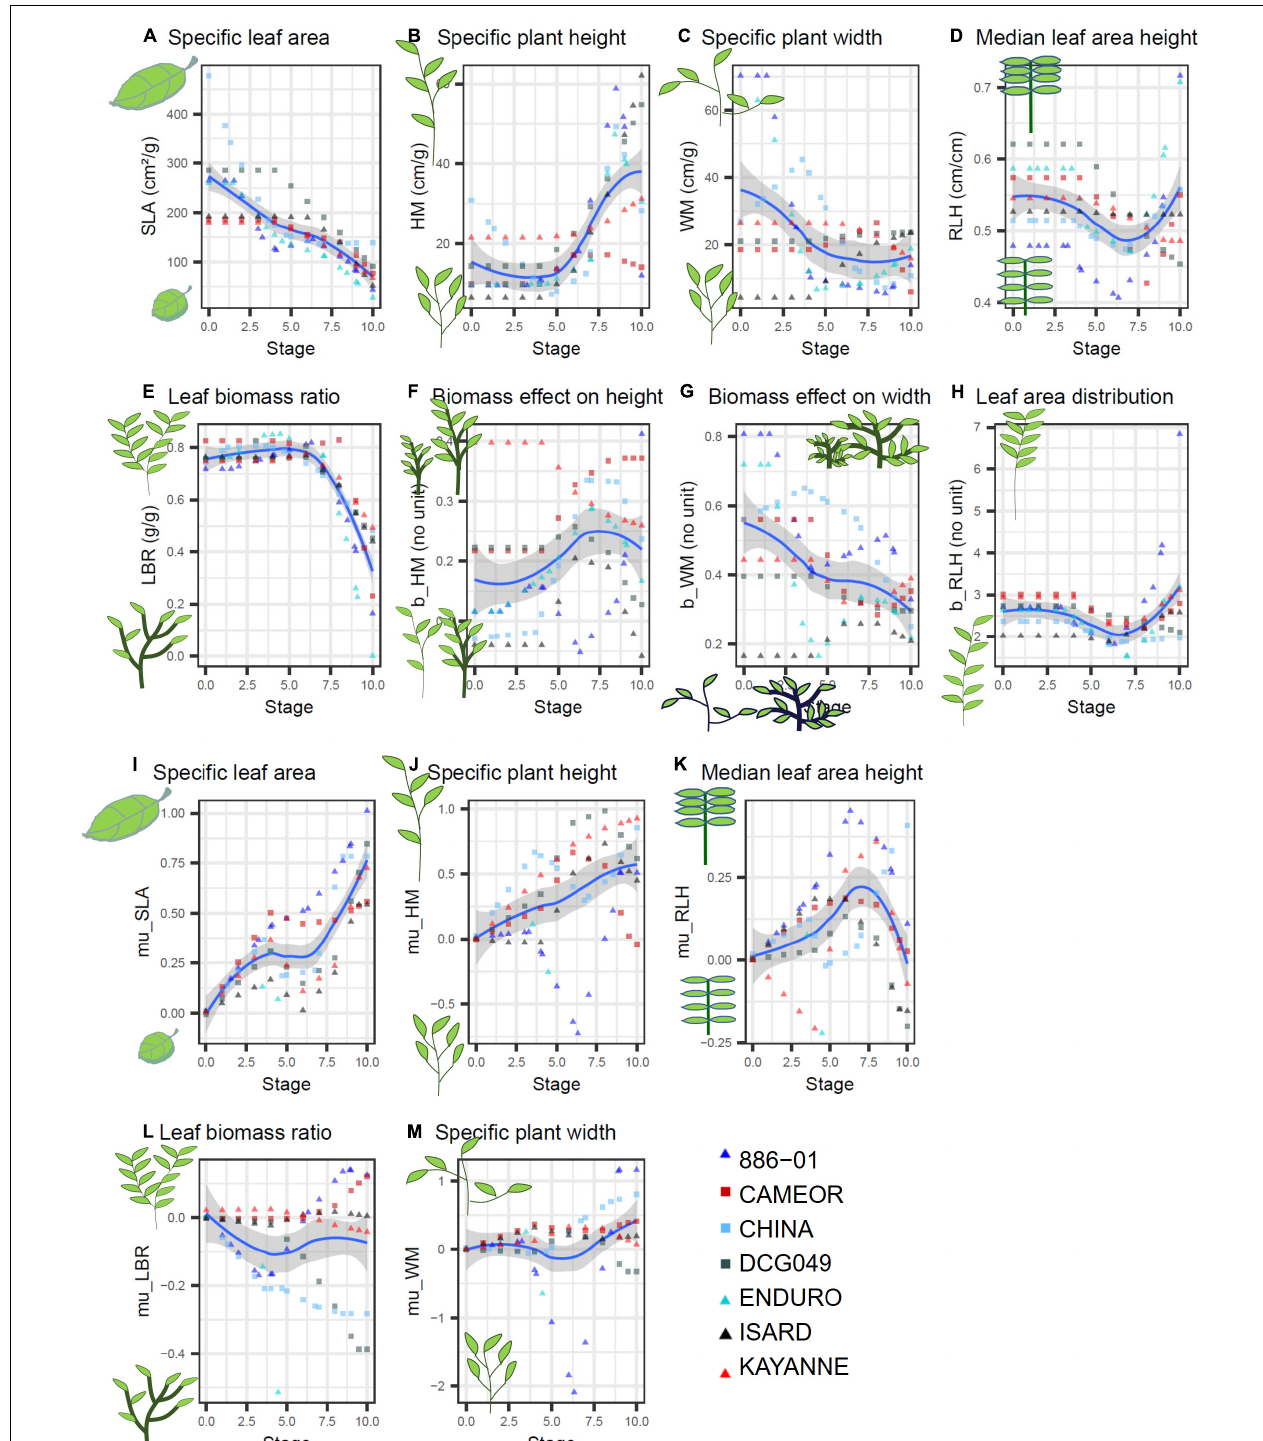
FIGURE 1 | Parameters describing potential plant morphology in unshaded conditions (A–H) and shading response (I–M) measured on 7 pea varieties (red symbols = spring varieties, blueish colors = winter varieties, (cid:78) = afila, (cid:4) = Leafy) over plant stages (BBCH) estimated from garden-plot experiments. SLA, plant leaf area/plant leaf biomass; LBR, plant leaf biomass/plant above-ground biomass; HM, plant height/plant above-ground biomass b_HM ; WM, plant width/plant above-ground biomass b_WM ; RLH, plant height below which 50% of leaf area are located/total plant height; b_RLH, shape parameter for leaf area distribution along plant height. mu_X shapes shade response of morphogical variable X (SLA, LBR, etc.) via X = X unshaded · exp(-mu_X · shading intensity) (Colbach, 2020